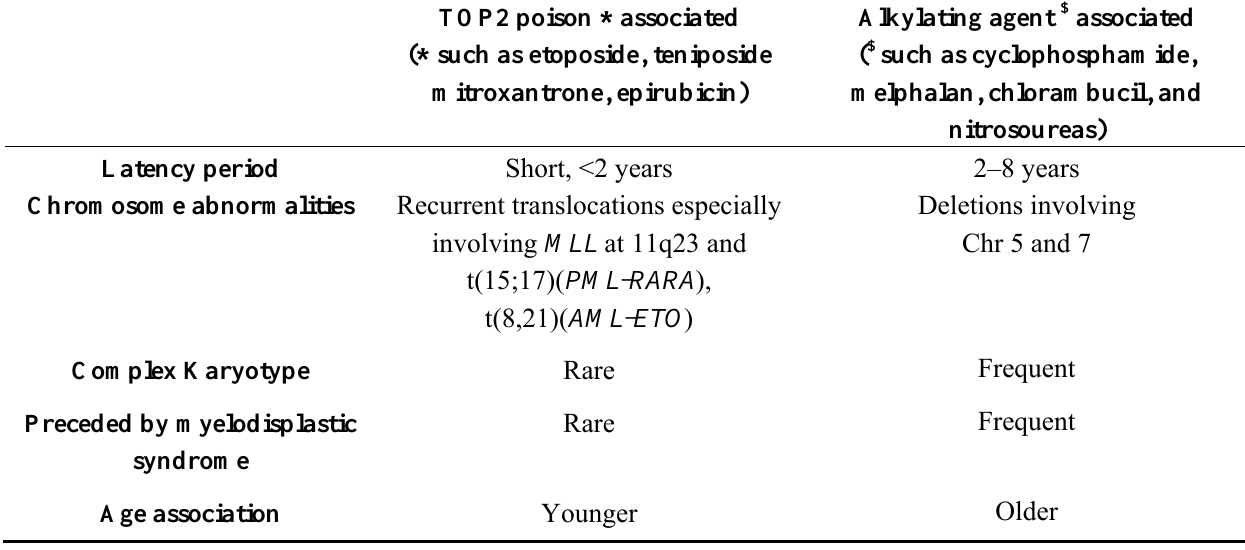
Table 1. Typical biological and clinical characteristics of t-AML cases associated with alkylating agents and TOP2